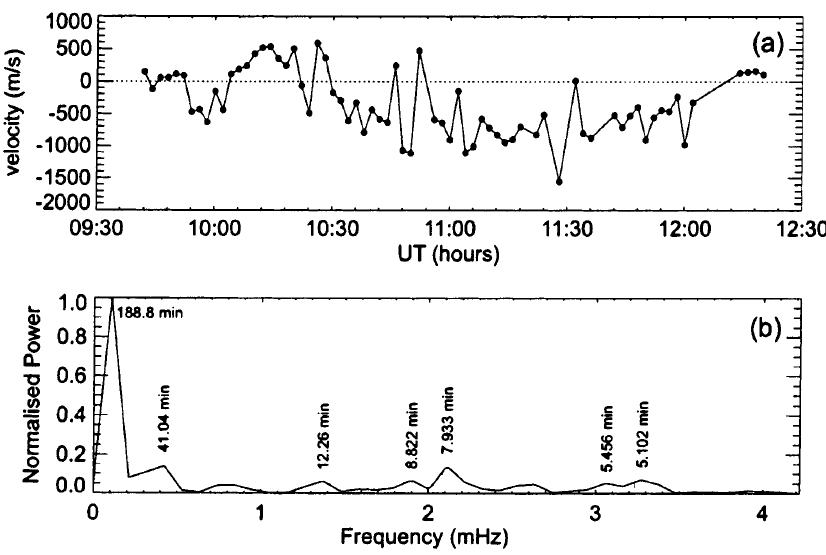
Fig. 3. a The CUTLASS velocity time series from beam 15, range 52 on 3 January, 1996, between 09:30 and 12:30 UT. b The Fourier spectrum of CUTLASS velocity time series in a normalised to the peak power. Fluctuations above the 5% mini- mum normalised power threshold occur at approximately 189, 41, 12, 9, 8, and 5 min